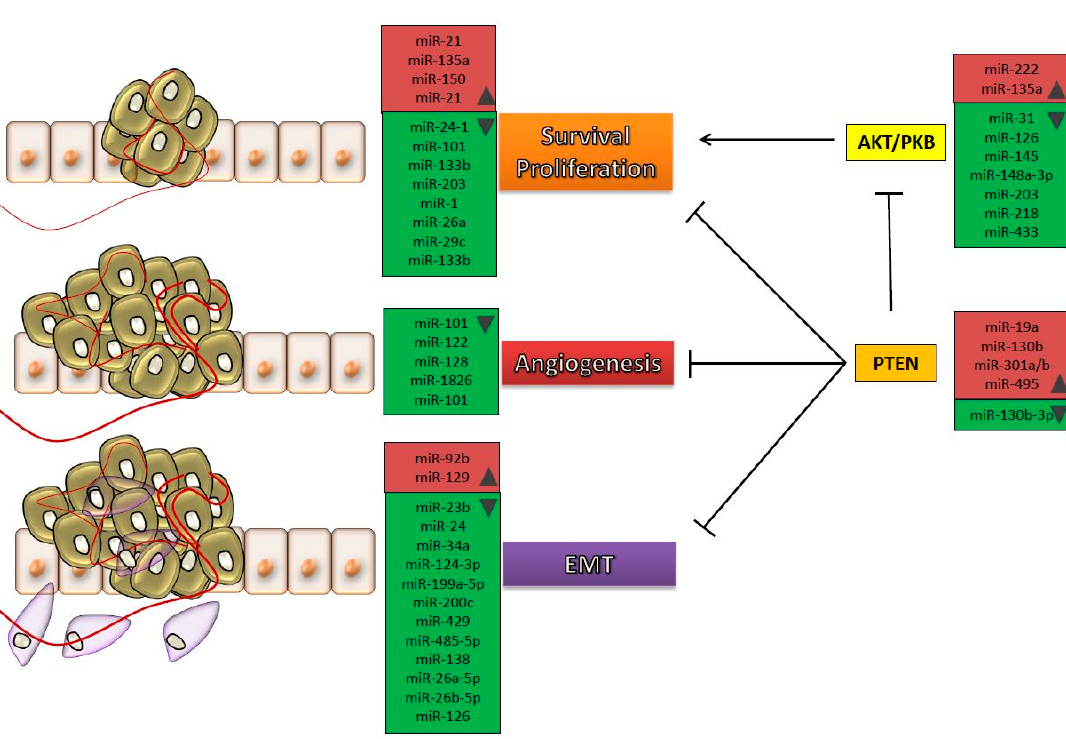
Figure 1. Processes affected by different microRNAs (miRNAs) that were found to be dysregulated in patients with bladder cancer. Cancer cells are subjected to different molecular mechanisms in order to proliferate and invade secondary sites. The main hallmarks consist in survival and proliferation, development of new vascular networks and acquisition of invasive characteristics within epithelial to mesenchymal transition (EMT). All these processes are controlled by aberrantly expressed miRNAs, throughout the progression of tumor cells towards metastasis. In red are represented the upregulated microRNAs and in green those downregulated in bladder cancer; the arrow represents promotion of a process, and the T bar represents suppression of a process.